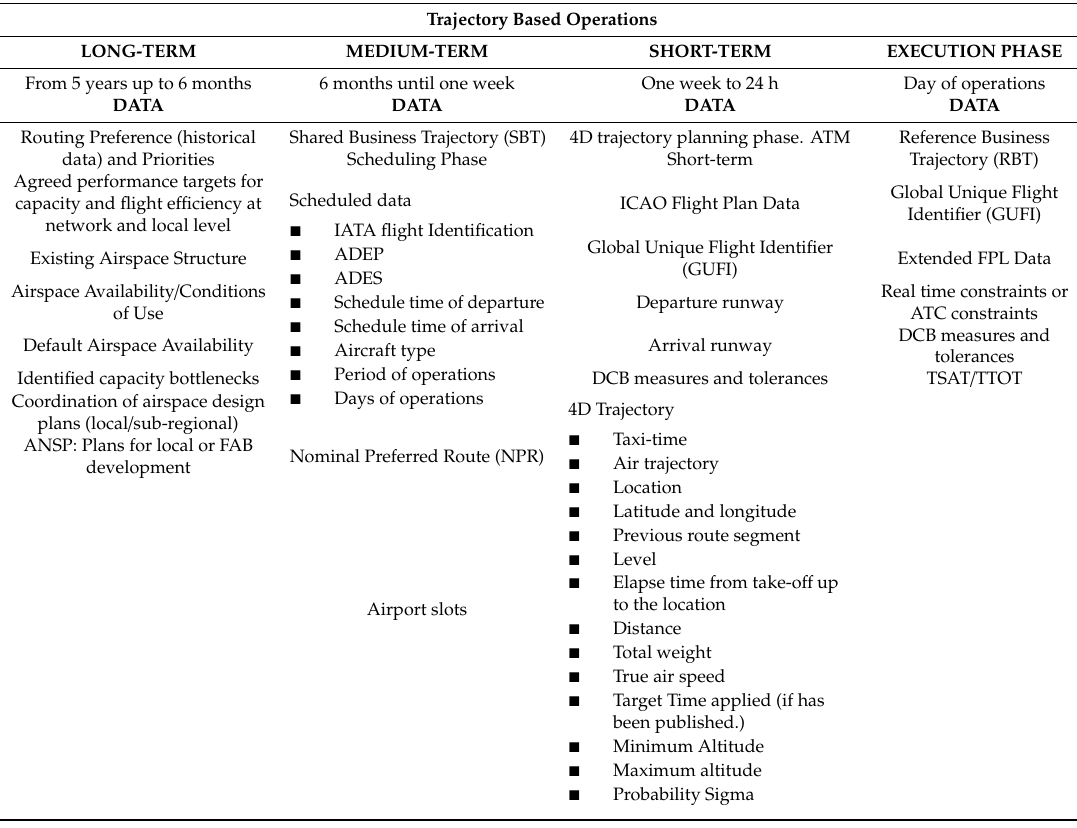
Table 1. Information available per time